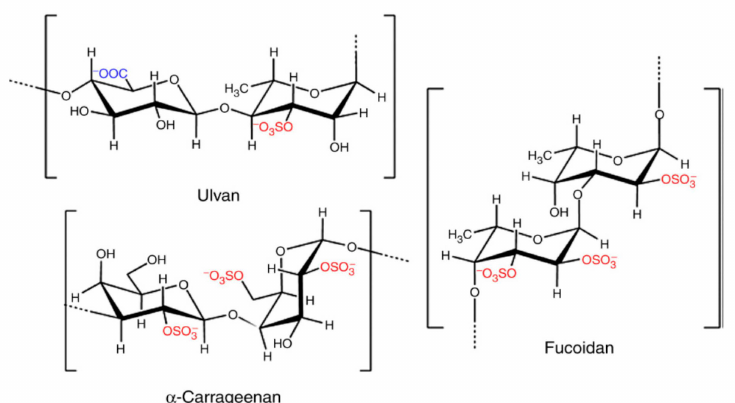
Figure 5. The structures of repeating units from the representative sulphated polysaccharides of macroalgal origin, adapted from [174,175]. In red color are highlighted the sulphated groups. In blue are the repetitive specific units (L-fucose, L-rhamnose and D-galactose).